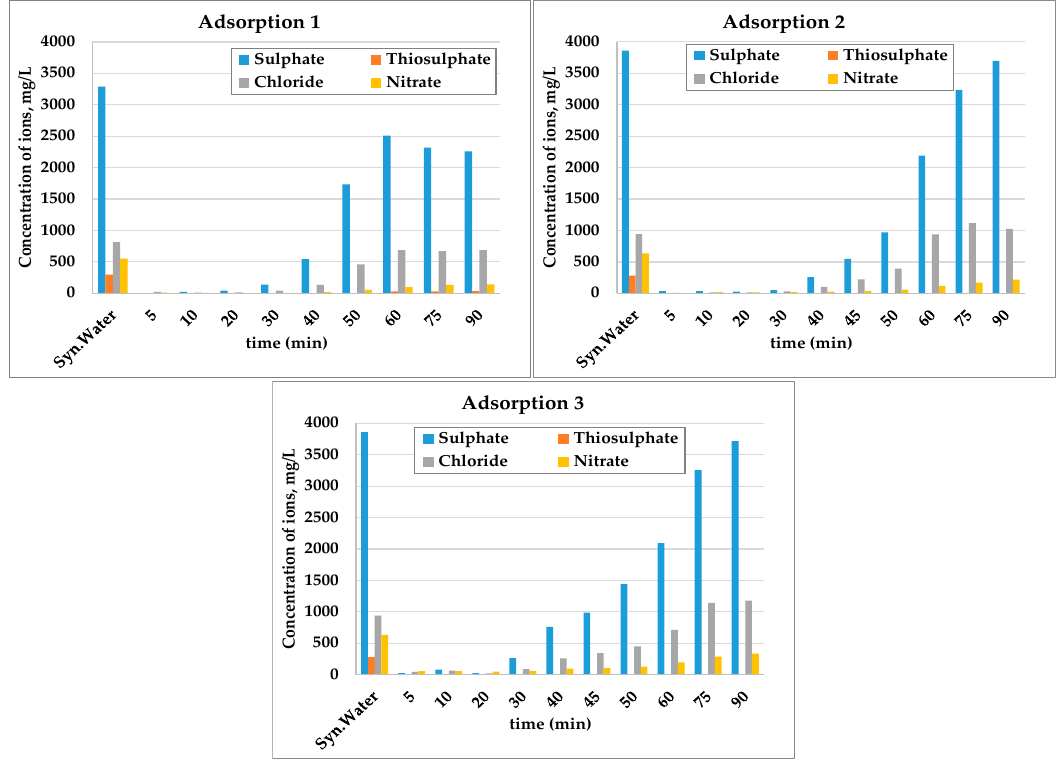
Figure 4. Residual anion concentrations in adsorption stages.